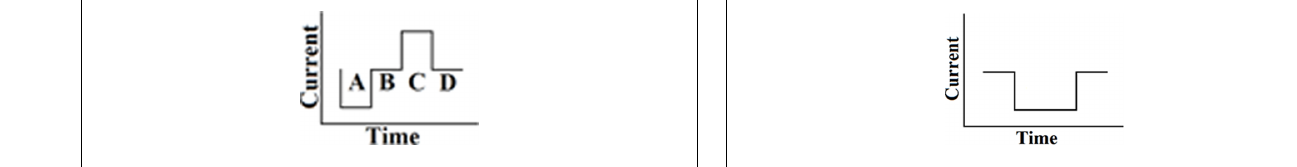
FIGURE 1 | Biphasic rectangular pulse. This means that there are two phases with charge delivery.The first phase is the cathodic (negative) one (A) , after that there is a delay (B) .The anodic (positive) phase follows (C) , which has the same charge as the cathodic one, but with a positive charge instead of a negative. In this way the charge remains balanced.The last phase is the resting phase (D) .The duration of it determines the frequency of the stimulus. A longer duration of phase D implies less pulses per second (pps) and thus a lower stimulus frequency.The shape of all the phases are rectangular and a current is delivered, instead of a voltage.